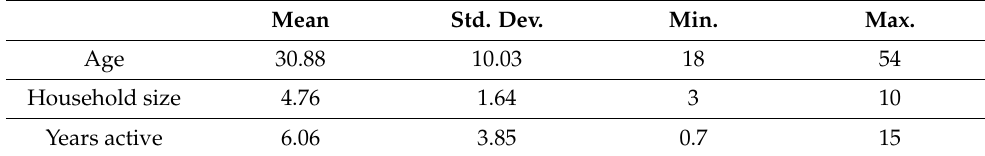
Table 1. Summary statistics of the easy-bike drivers’ profile ( n = 70). Mean Std. Dev. Min.